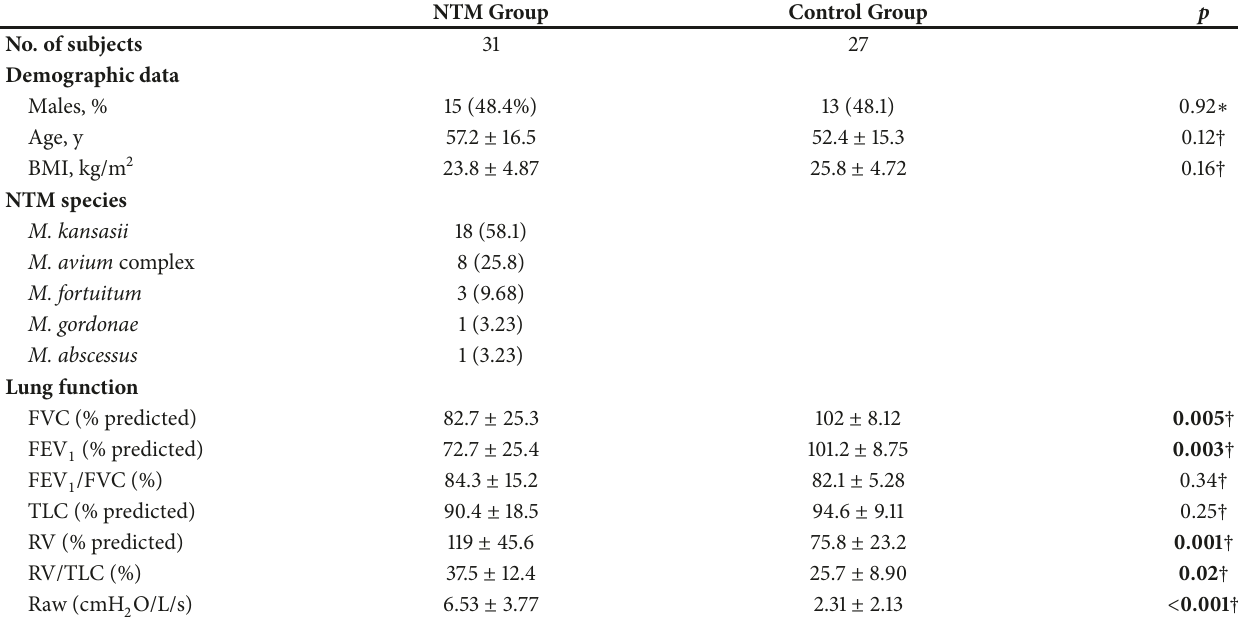
Table 1: Patients and control subjects